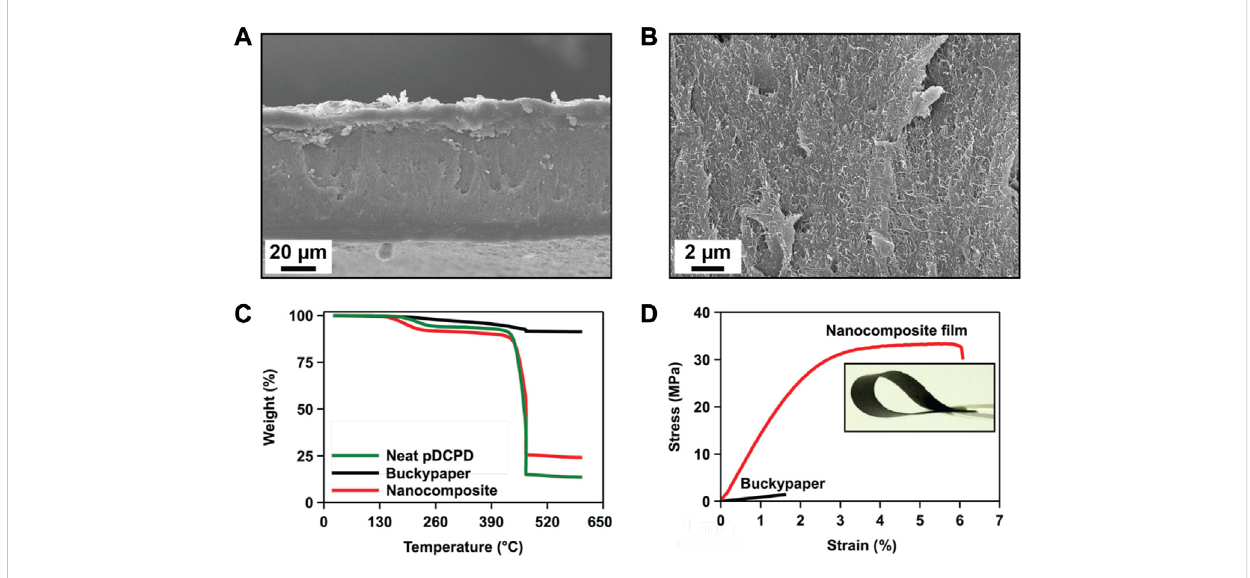
FIGURE 3 Characterization of polymer nanocomposite fi lms. (A, B) Scanning electron microscopy (SEM) micrographs from the cross-section of a nanocomposite fi lm. (C) TGA pro fi les of pristine buckypaper, neat cured pDCPD fi lm, and nanocomposite fi lm. (D) Tensile stress-strain curves of pristine